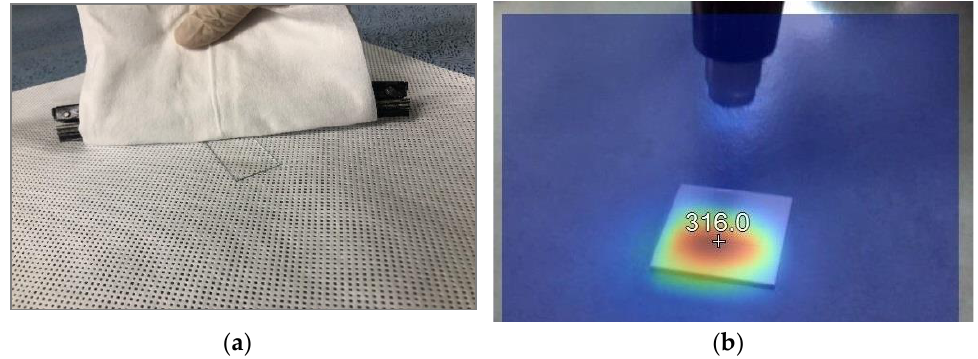
Figure 1. Process of the functional films used in this work: ( a ) bar coating, ( b ) hot-air fan annealing.